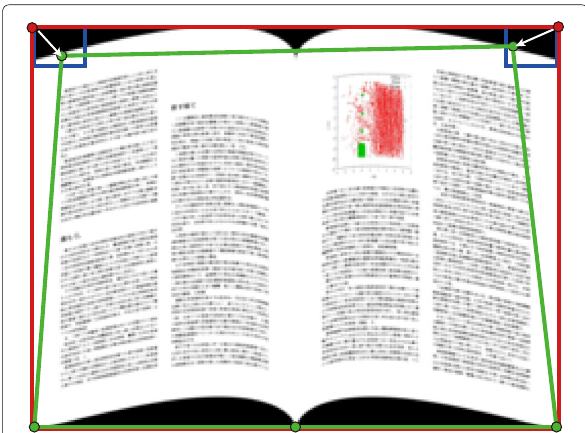
Fig. 4 Perspective projection by a randomly determined homography matrix